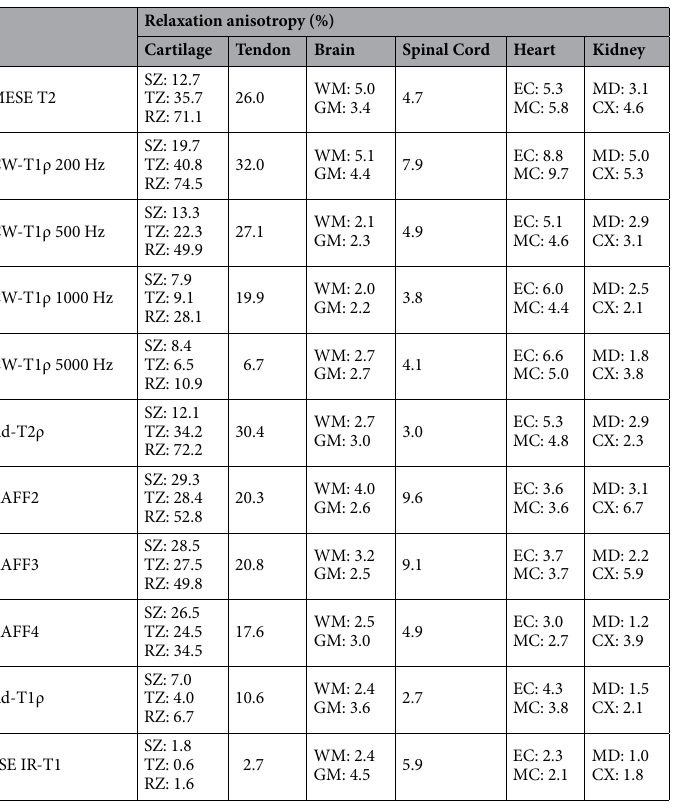
Table 1. Average relaxation anisotropy of qMRI parameters in different tissues in the specified ROIs (Figs. 1C, 3C and 5C). Cartilage ROIs: SZ superficial zone, TZ translational zone, RZ radial zone. ROIs in brain: GM gray matter, WM white matter. Cardiac ROIs: EC epicardium, MC mesocardium. Kidney ROIs: MD medulla, CX